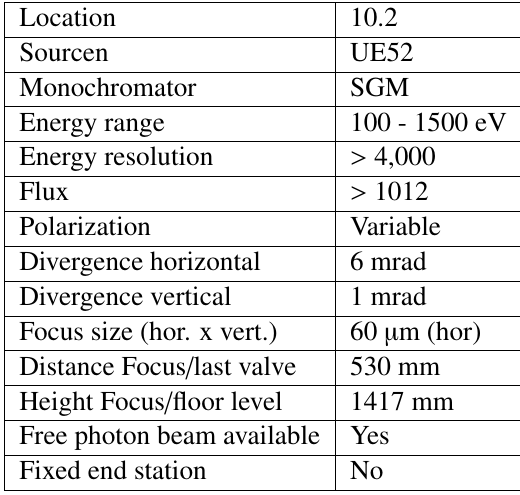
Table 3: Technical data of Beamline UE52